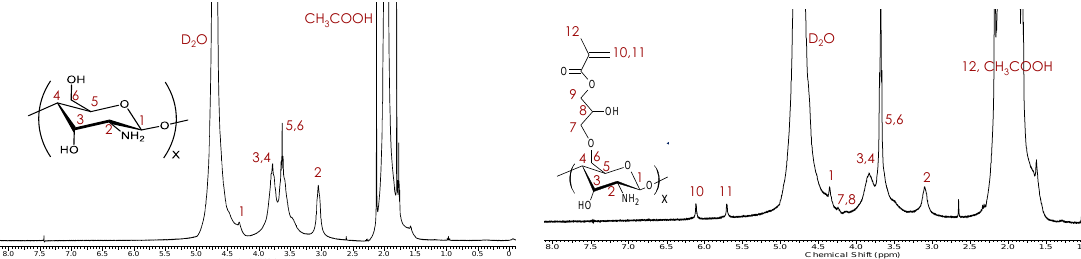
Figure 1. 1 H NMR collected in 0.4 M CH 3 COOH/D 2 O (5 mg/mL) of pure chitosan ( left ) and CTS– g – GMA ( right ).